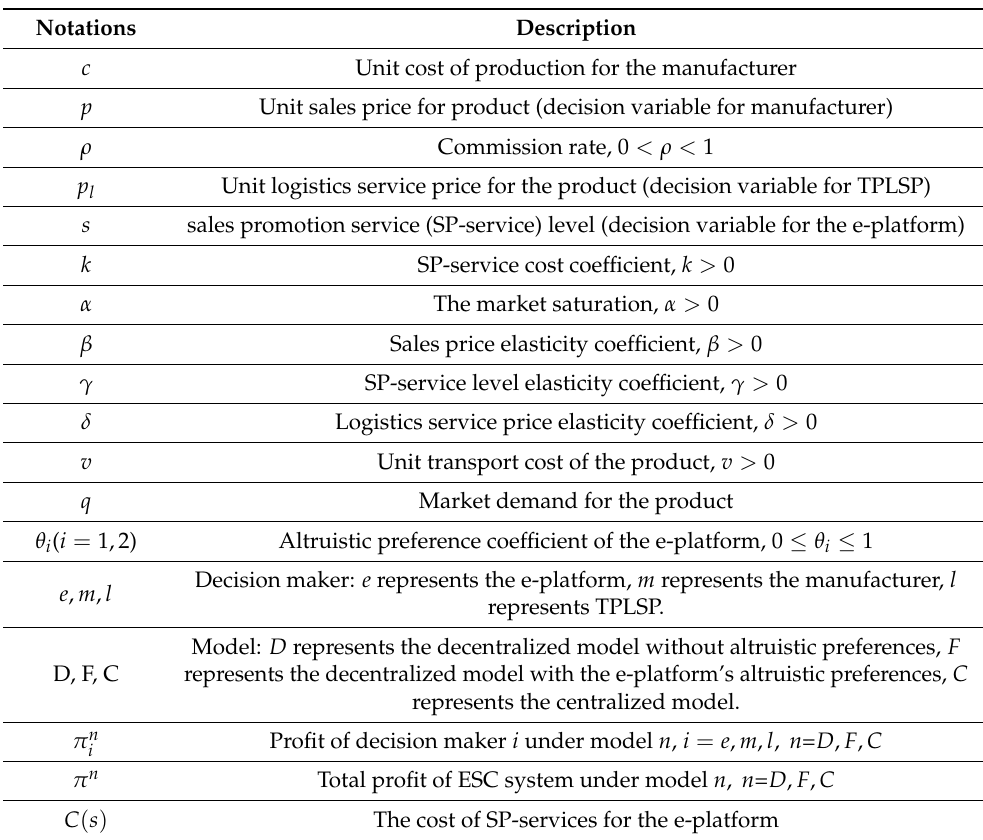
Table 2. Notations